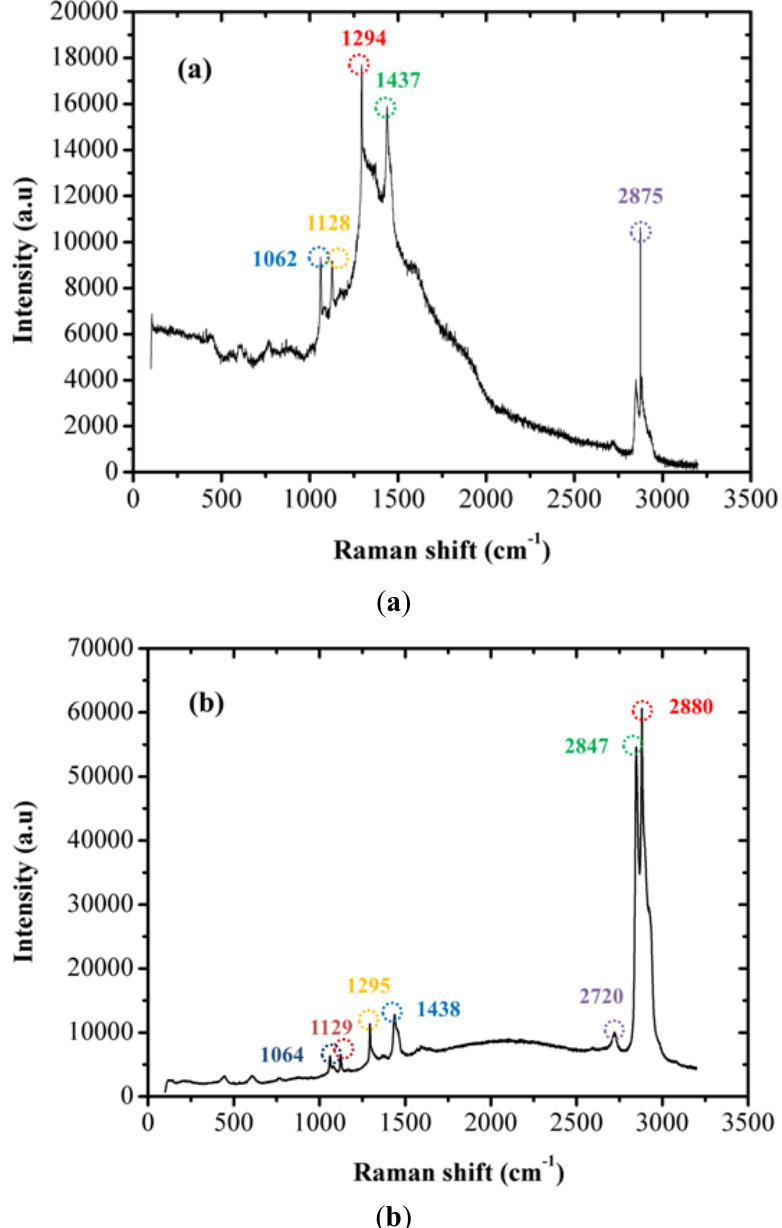
Figure 9. Raman spectrum of EMAA powder ( a ) Excitation wavelength at 785 nm; ( b ) Excitation wavelength at 514